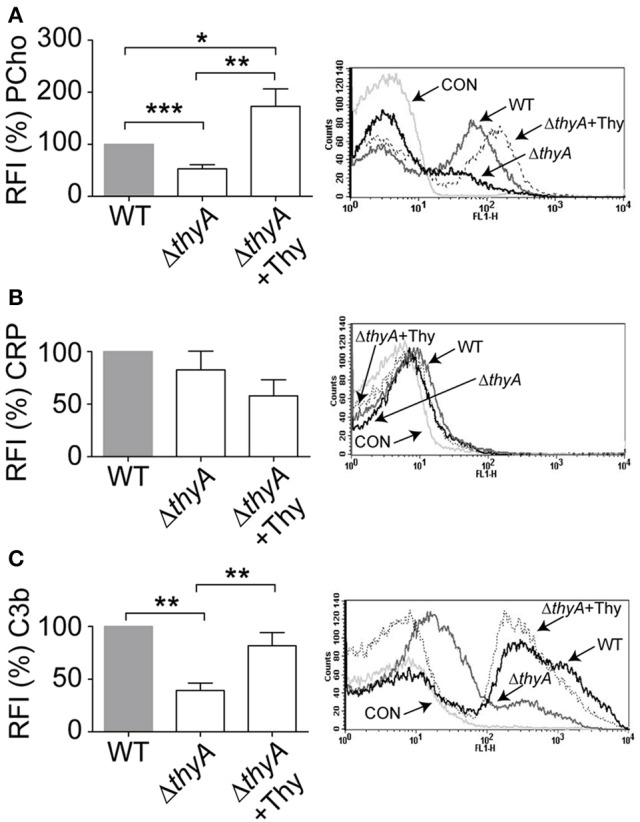
Thymidine auxotrophy reduces PCho level and C3b binding on NTHi375. NTHi375 WT and ΔthyA strains were exponentially grown in sBHI, in the absence or presence of thymidine 300 μg/ml, and incubated with anti-PCho (A), human serum and anti-CRP (B) or human serum and anti-C3b (C) antibodies. Binding was analyzed by flow cytometry. Representative flow cytometry histograms for each assay are shown (right). Color code: light gray, control (CON) buffer; gray, NTHi375; black, NTHi375ΔthyA; dotted lane, NTHi375ΔthyA grown in sBHI+Thy. NTHi375ΔthyA showed significantly lower PCho level (p < 0.0001) and C3b deposition (p < 0.01) than the WT strain, which was restored by mutant bacterial growth in sBHI with thymidine 300 μg/ml (PCho, p < 0.01; C3b, p < 0.01). PCho detection was significantly higher in NTHi375ΔthyA grown in sBHI supplemented with thymidine than in the WT strain (p < 0.05). *p < 0.05, **p < 0.01, ***p < 0.0001.